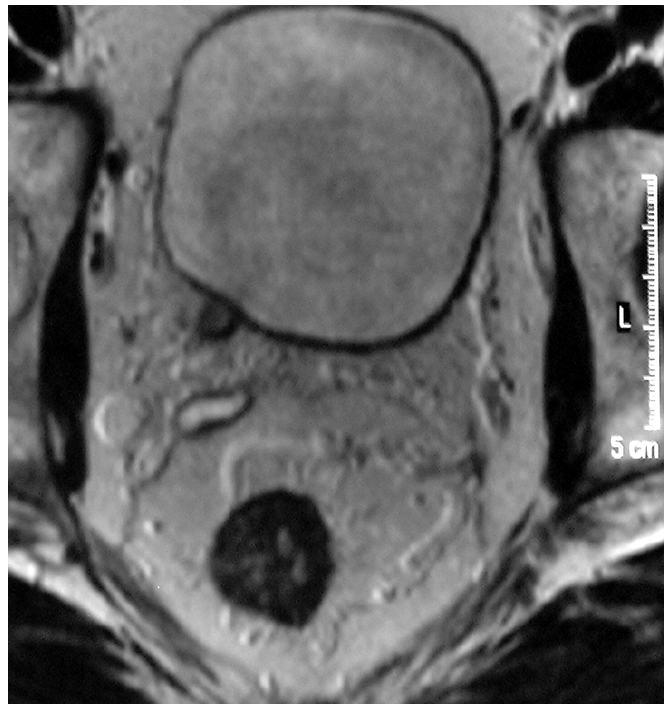
FIGURE 2 . MRI demonstrating absent left seminal vesicle and